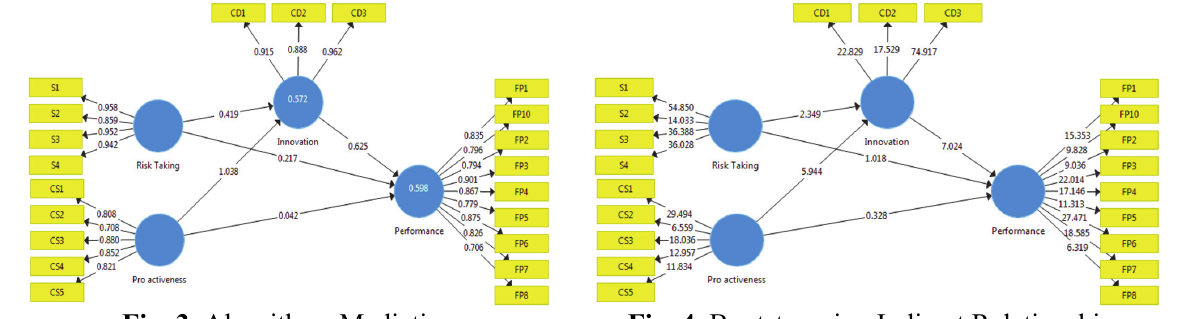
Fig. 3. Algorithms Mediation Fig. 4. Bootstrapping Indirect Relationships